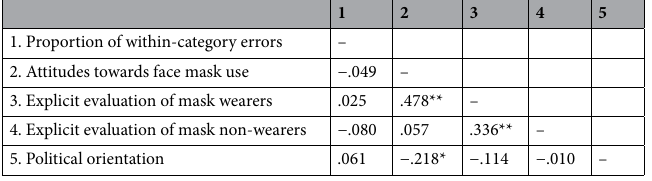
Table 1. Correlations in Study 1. * p < .005; ** p <